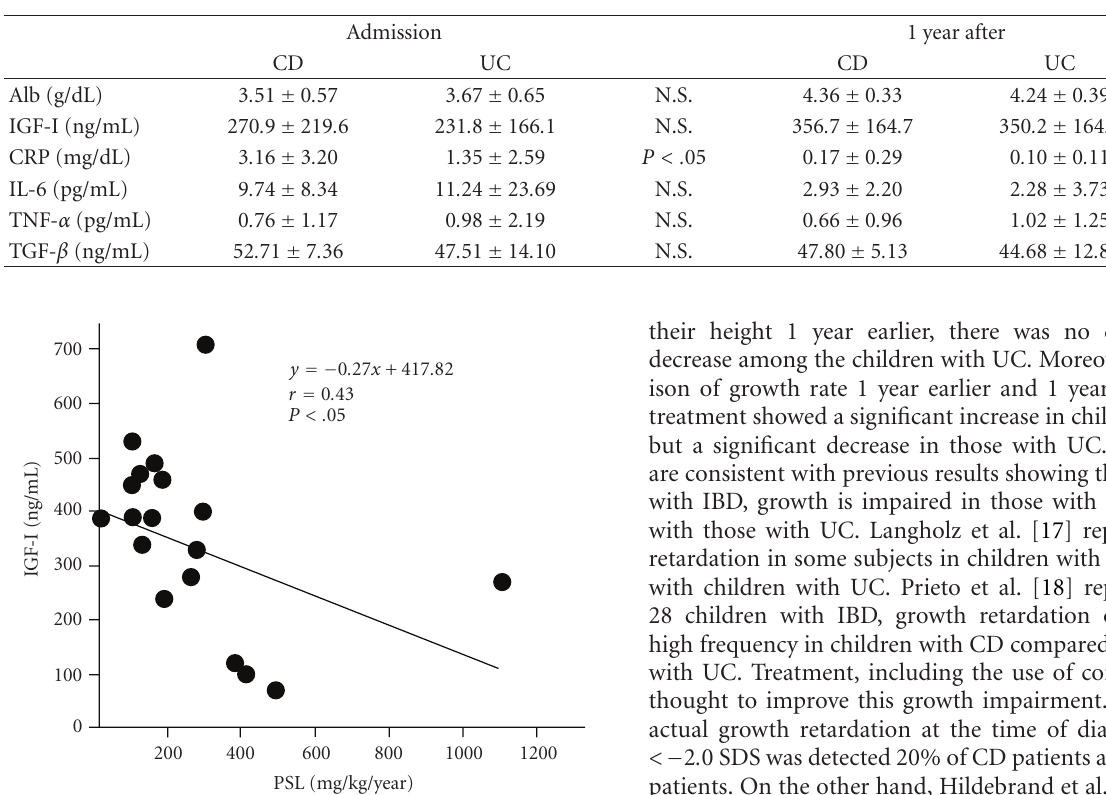
Table 2: Comparison of various parameters at initial assessment and 1 year after the start of treatment in children with CD and those with UC (mean ± SD).